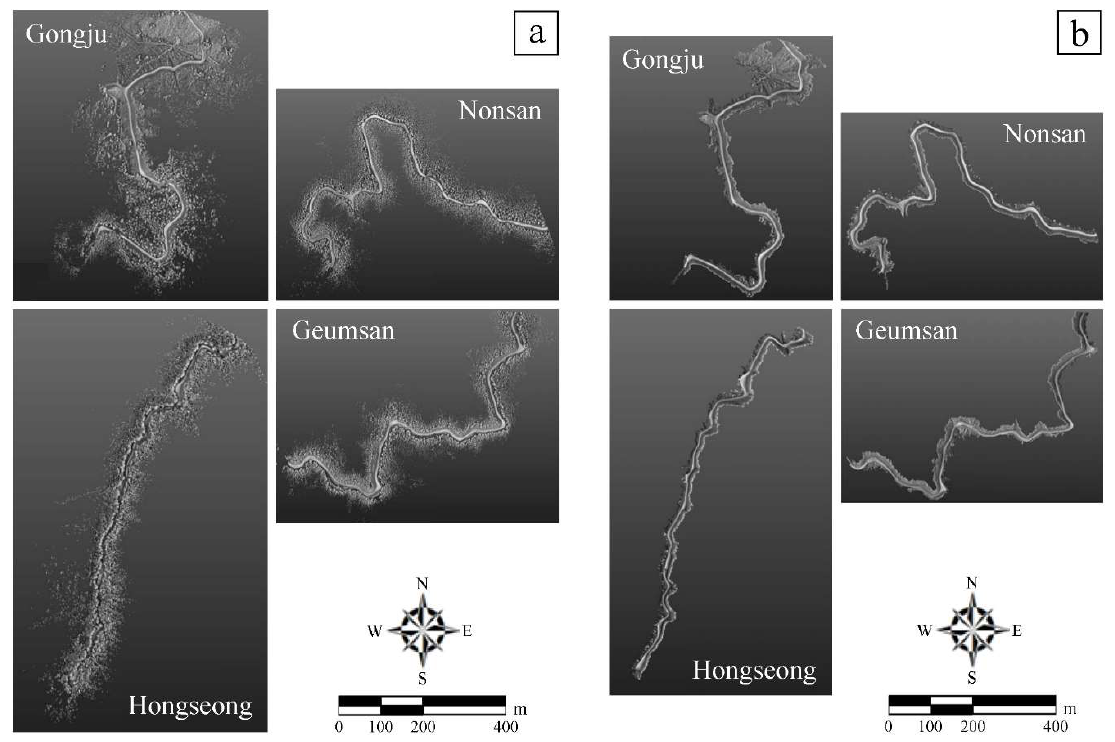
Figure 5. The 3D maps created using point cloud data obtained from the Mobile Laser Scanner (MLS) survey on the study forest roads. The map ( a ) before and ( b ) after removing point cloud data displaying vegetation on the outsides of cut-and-fill slopes.